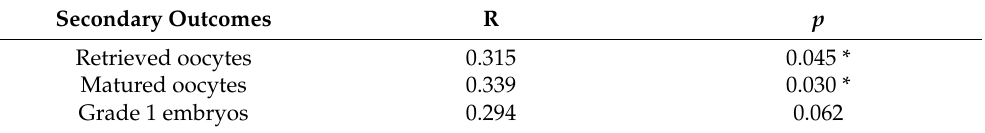
Table 4. Correlation between recreational physical activity (RPA) measured by GPAQ-H and sec- ondary outcomes of IVF/ICSI by women who reached at least 150 min